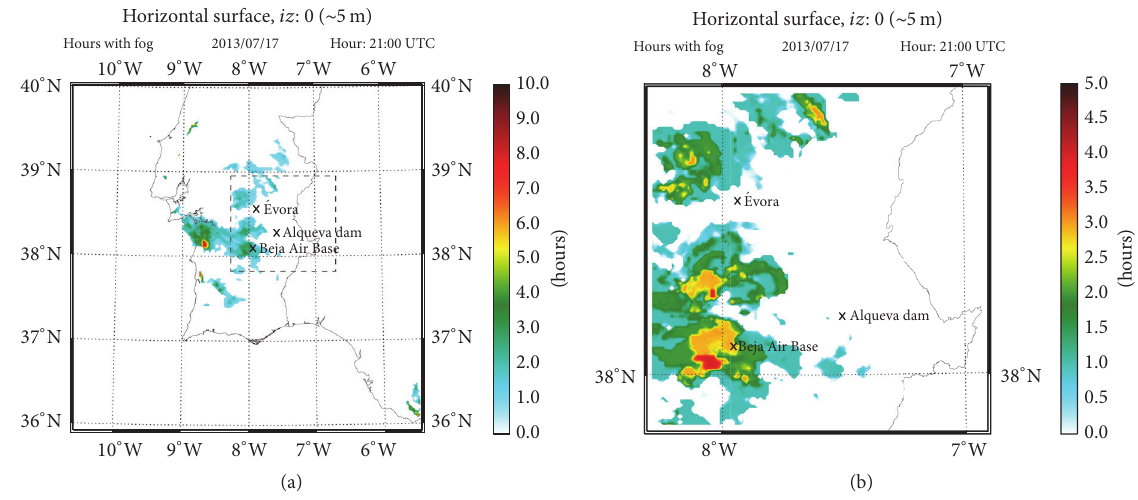
Figure 14: Simulation of the “number of hours with fog” in the two domains, between 21:00 and 12:00 UTC.